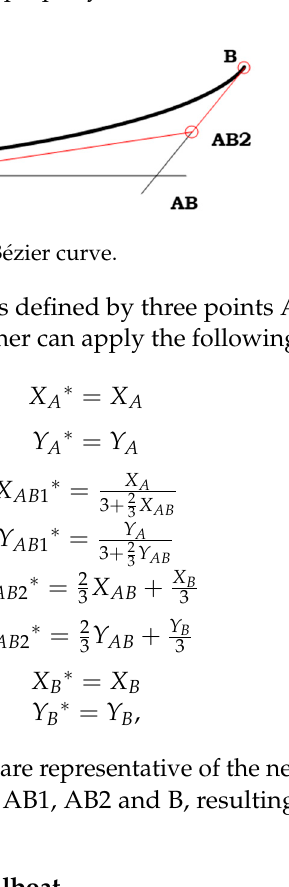
Figure 3. Two rational Bézier curves with a point in common.